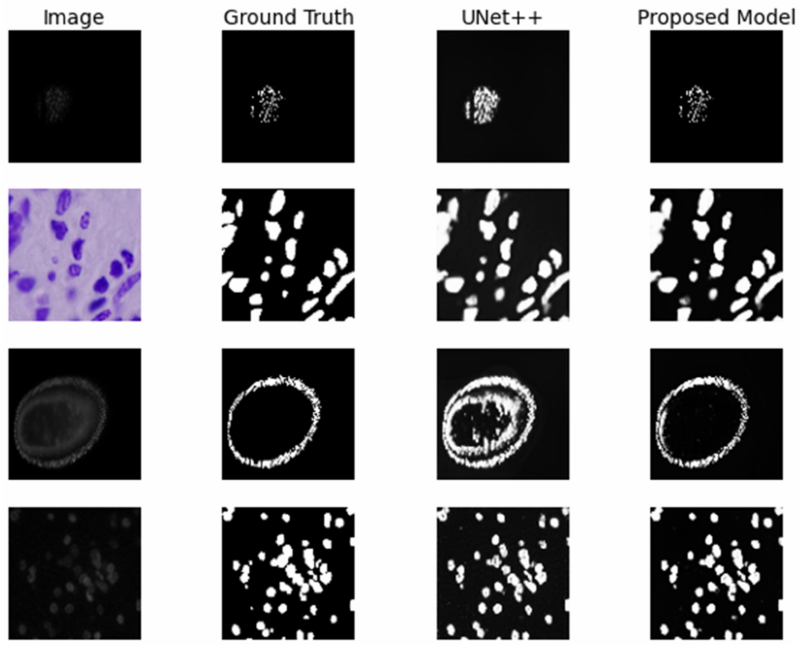
Figure 13. Qualitative assessment of the performance of UNet++ and Residual-Attention UNet++ on cell